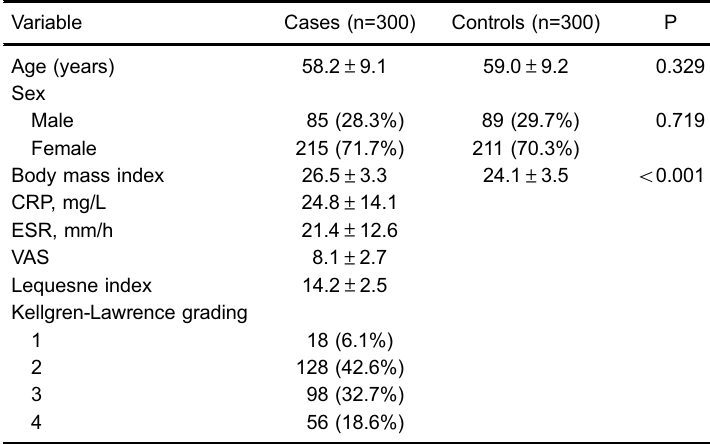
Chr pos: chromosome position. Table 2. Patient demographics and risk factors for knee